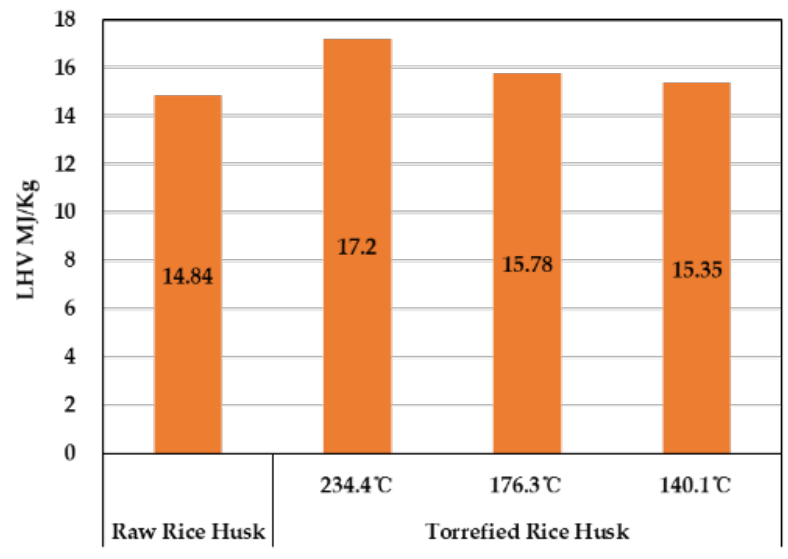
Figure 10. Comparison of low heat value between rice husks and torrefied rice husks.